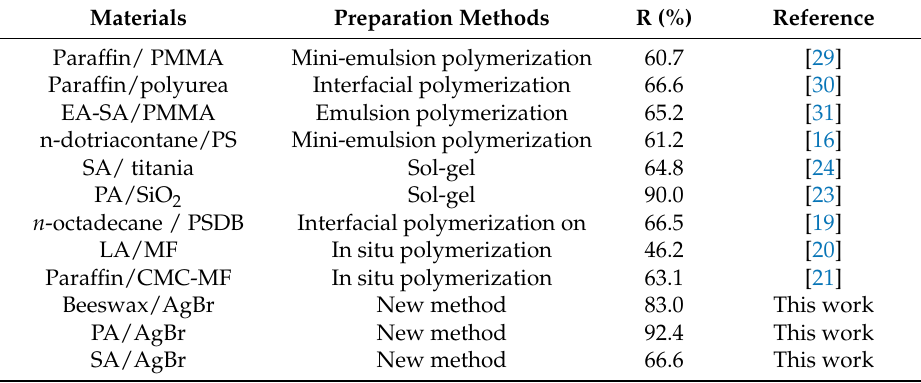
Table 4. Comparison of the encapsulation ratio of the micro/nanocapsules prepared in this work with that of other methods.